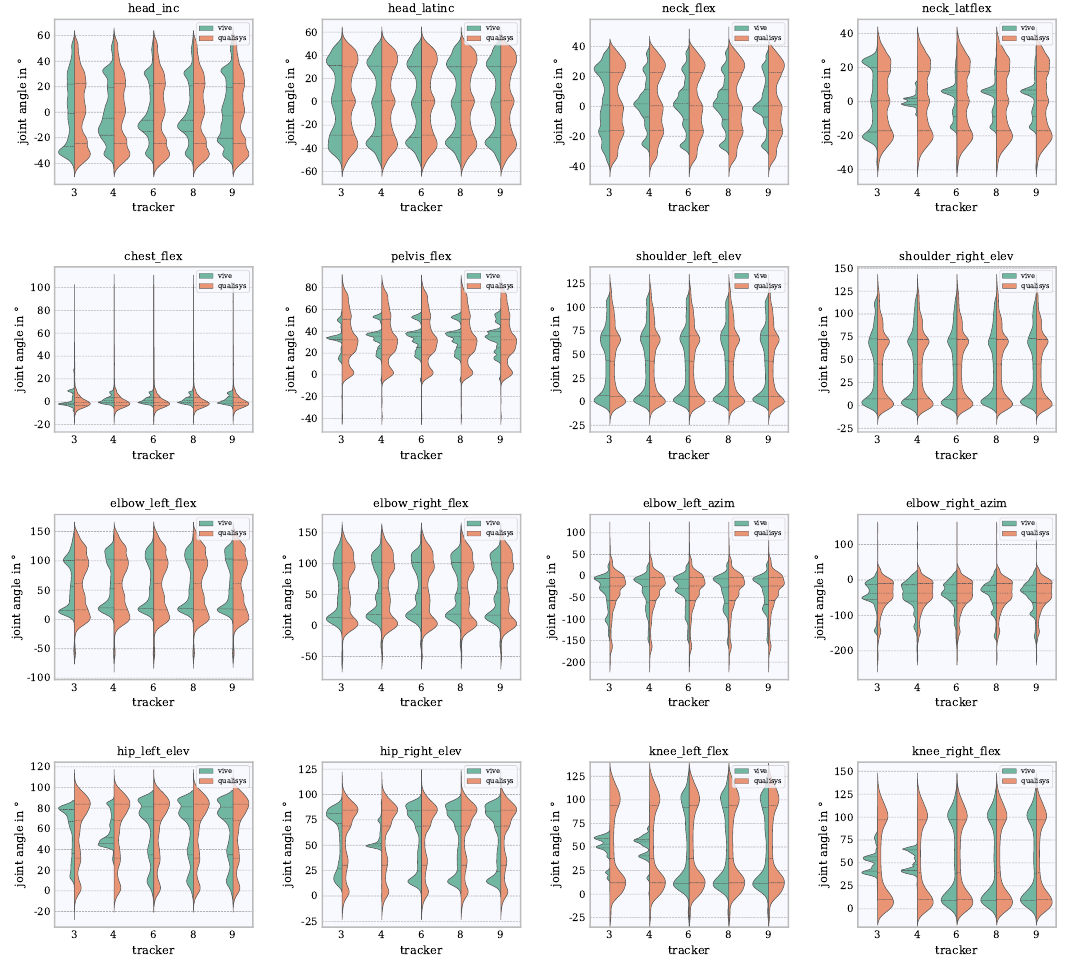
Figure 9. Violin representation of the examined joint angles of the Vive tracker configurations 3, 4, 6, 8 and 9 (left violin, green) in comparison to Qualisys (right violin, orange). The quartiles (25%, 50% and 75%) are shown as dotted